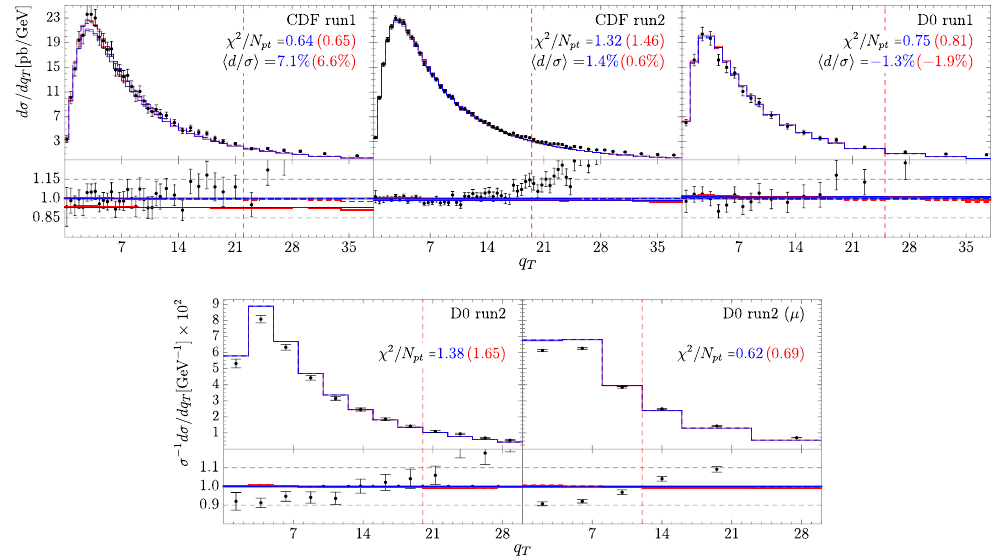
Figure 14 . Di(cid:11)erential cross-section for the Z=(cid:13) (cid:3) boson production measured by CDF and D0 at di(cid:11)erent values of s . The (cid:12)gure elements are the same as in (cid:12)gure 12.